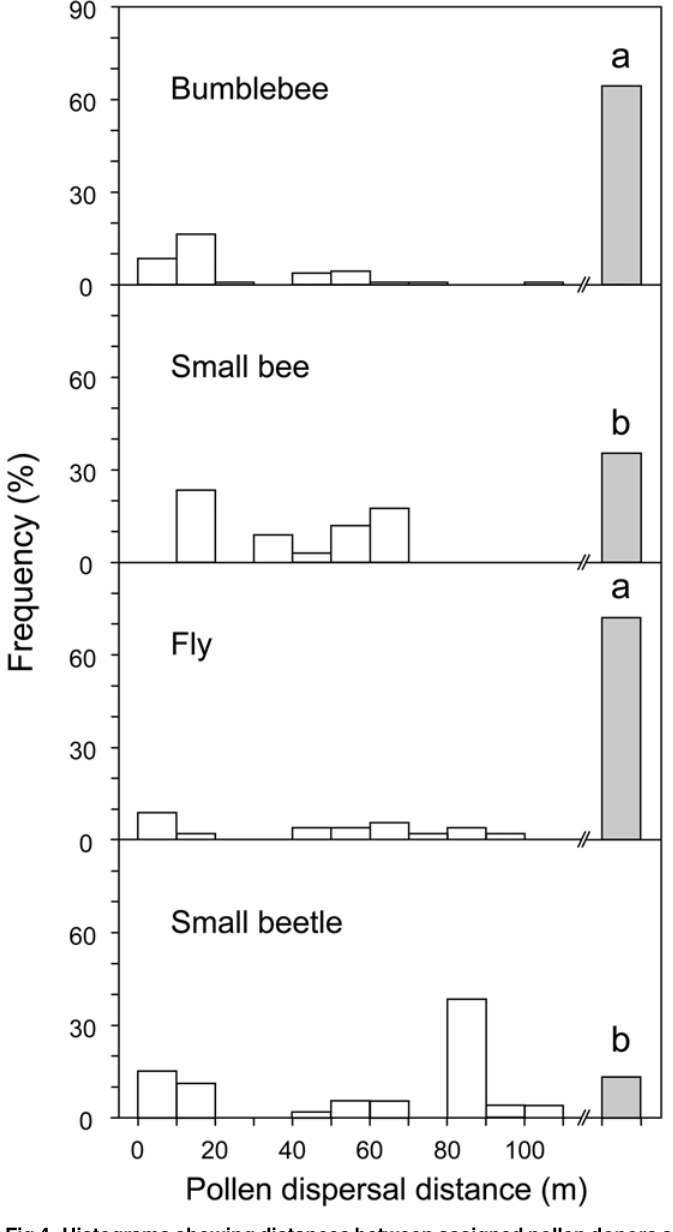
Fig 4. Histograms showing distances between assigned pollen donors and the trees from which insects were collected. Gray bars indicate the proportion of pollen from outside the plot found on insects. Values with different letters are significantly different at P < 0.05 ( χ 2 test followed by Ryan ’ s method as post hoc